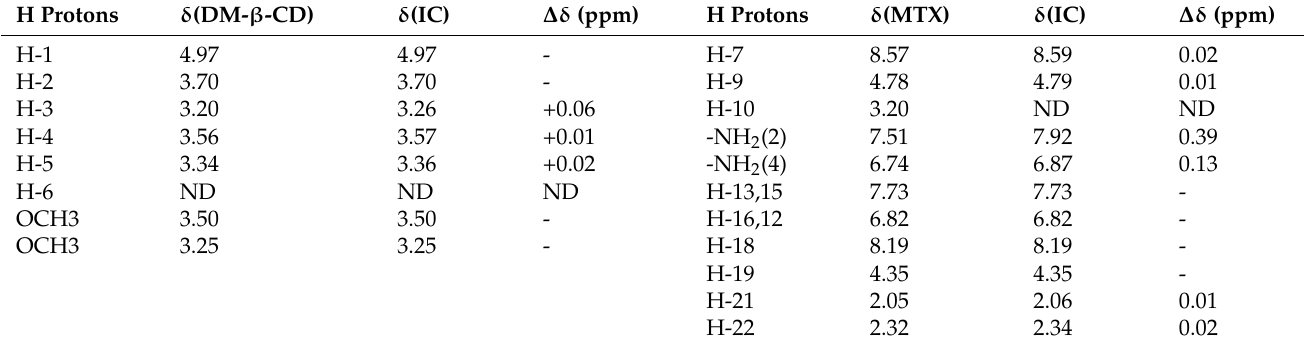
Table 4. Comparative 1 H-NMR chemical shifts of ( δ , ppm) studies of DM- β -CD, free MTX, MTX/DM- β -CD inclusion complex (IC), and their complexation induced shifts ( ∆ δ ). ( ∆ δ ppm = δ complex– δ free), ND: not